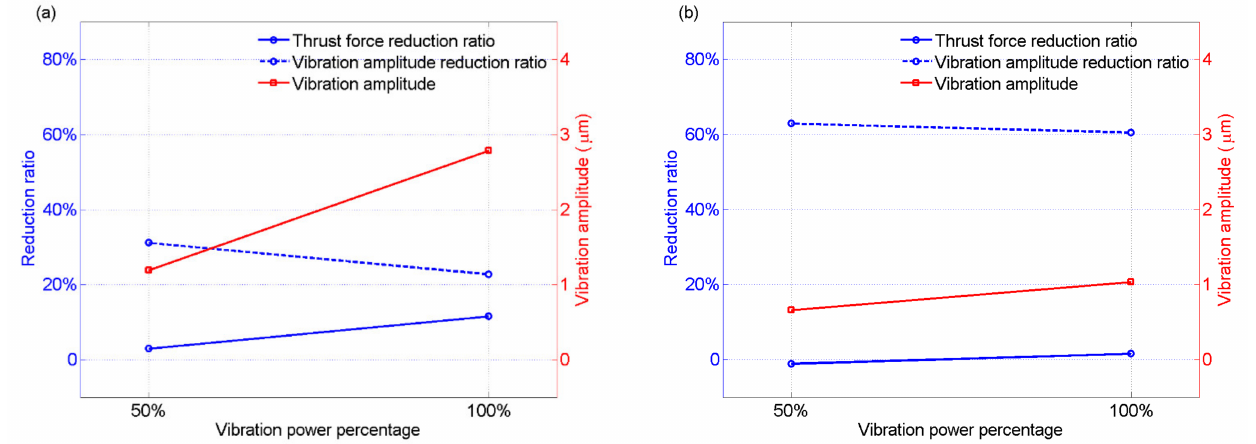
Figure 6. Effect of vibration amplitude on TFRR. ( a ) Spindle speed: 10,000 rpm, feed rate: 50 mm/min; ( b ) spindle speed: 800 rpm, feed rate: 500